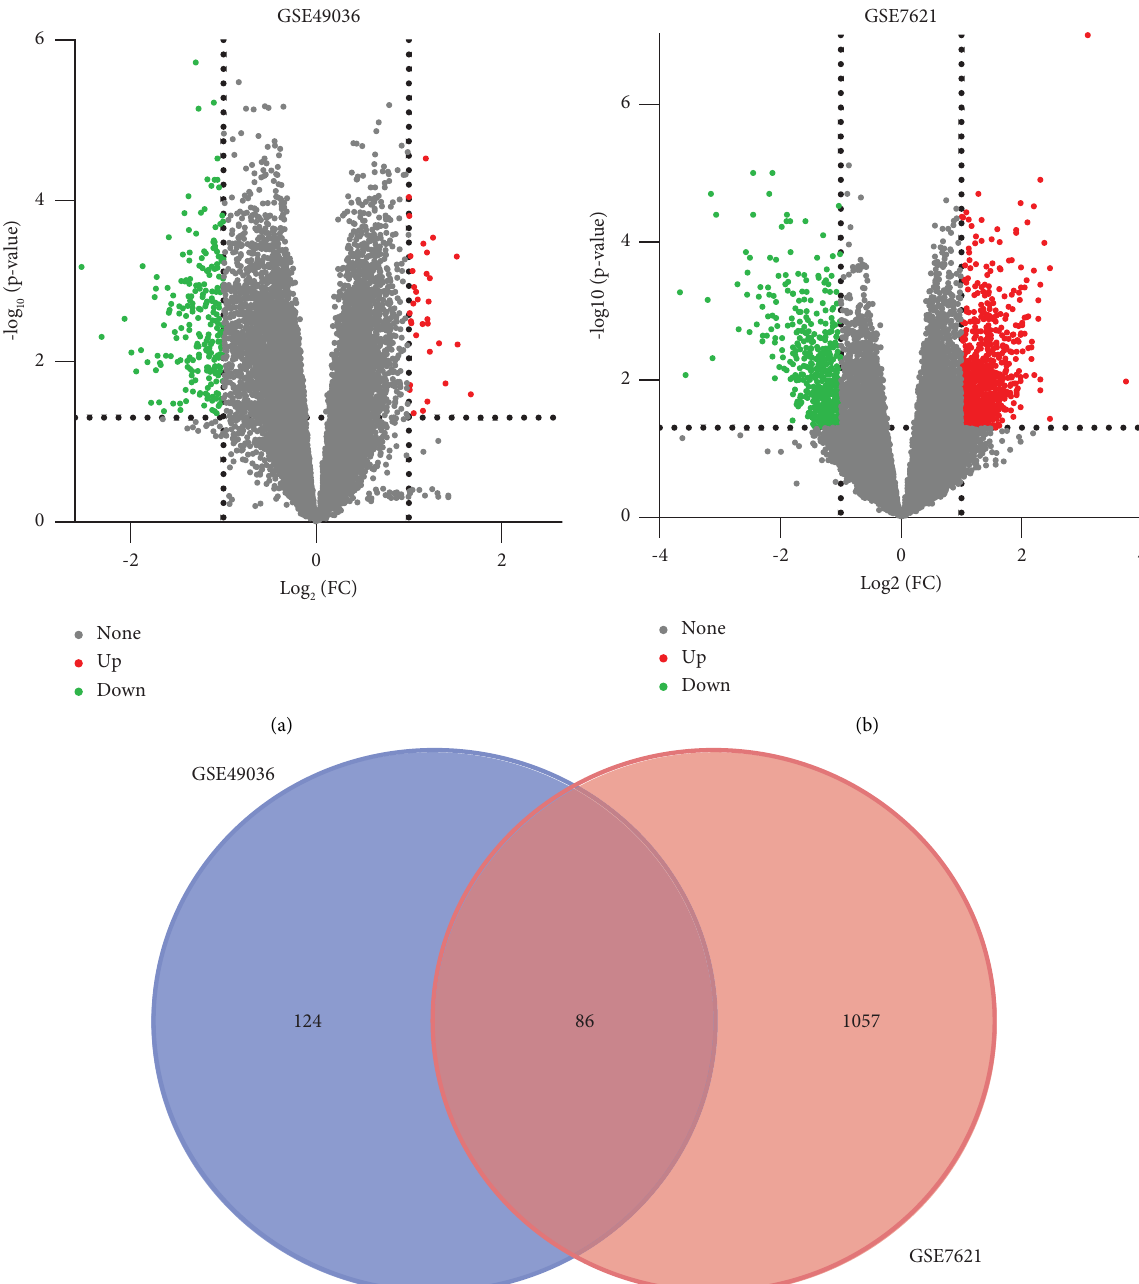
Figure 2: Te volcano plots of diferential expression of data between two sets of samples, Venn diagram. (a) Te GSE49036 dataset. (b) Te GSE7621 dataset. Te red points represent upregulated genes screened based on fold change ≥ 1.0 and P value < 0.05. Te green points represent the downregulated genes screened based on fold change ≤ − 1.0 and P value < 0.05. Te black points represent genes with no signifcant change. (c) Venn diagram of DEGs between GSE49036 and GSE7621. Te two datasets show an overlap of 86 genes. DEGs, diferentially expressed